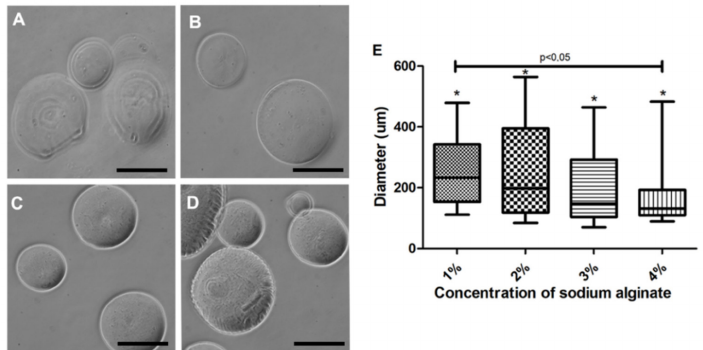
Figure 3. Morphological aspect of the microcapsules produced with the second prototype at a 20 cm distance. ( A ) 1% sodium alginate led to an altered membrane when viewed under light microscopy; ( B ) 2% sodium alginate presented a diameter variability (258 ± 154 µ m); ( C ) 3% sodium alginate produced capsules with the smoothest and most homogeneous membrane; ( D ) 4% sodium alginate produced smaller capsules (166 ± 97 µ m) with a more heterogeneous membrane. ( E ) Characterization of the diameter of the capsules produced with di ff erent sodium alginate concentrations. Photos recorded using light-field microscope in gray scale (Nikon); five independent experiments were performed in triplicate. * Values were considered statistically significant when p < 0.05. ns = non-significant. 200 µ m